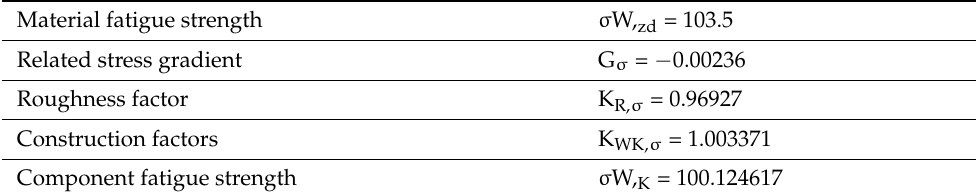
Table 12. Intermediate results of calculations (Ni-7Cr-3Fe + 60%